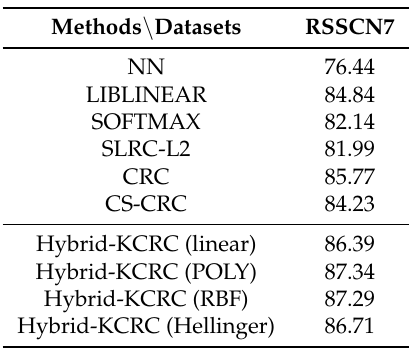
Table 3. Comparison with several classical classification methods on the RSSCN7 dataset